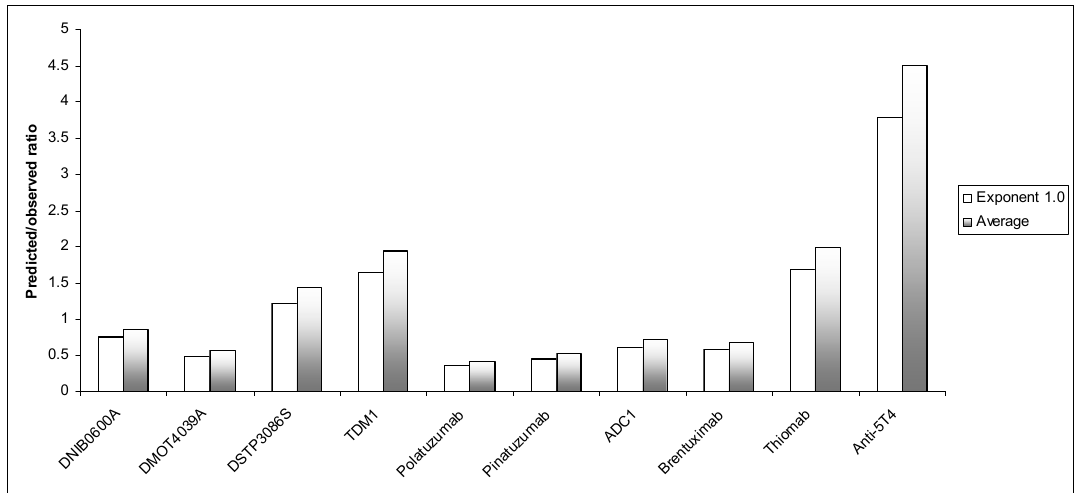
Figure 2. Predicted/observed ratio for the prediction of human clearance from mouse using exponent 1.0 or the average of different exponents (0.85, 1.0, and 1.1). A predicted/observed ratio of one indicates no prediction error.